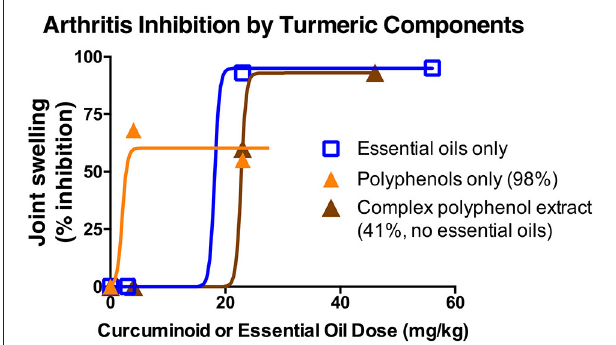
FIGURE 2 | Differential anti-arthritic effects of components extracted from turmeric rhizome in a pre-clinical arthritis model. The anti-arthritic effects of turmeric extracts of different chemical composition were assessed using an ip dosing strategy given reports of altered oral curcuminoid bioavailability when combined with essential oils. Each of turmeric’s secondary metabolites [curcuminoids (orange triangles) and essential oils (blue squares)] had significant anti-arthritic effects when administered separately. Interestingly, differential effects were noted for a chemically complex curcuminoid extract (brown triangles) devoid of essential oils but containing polar compounds, such as polysaccharides. Anti-arthritic curcuminoid efficacy was confirmed with oral dosing [50% inhibition; human equivalent dose (HED) of 1 g/d], while protection from oral essential oils was much reduced (20%; HED of 5 g/d) (